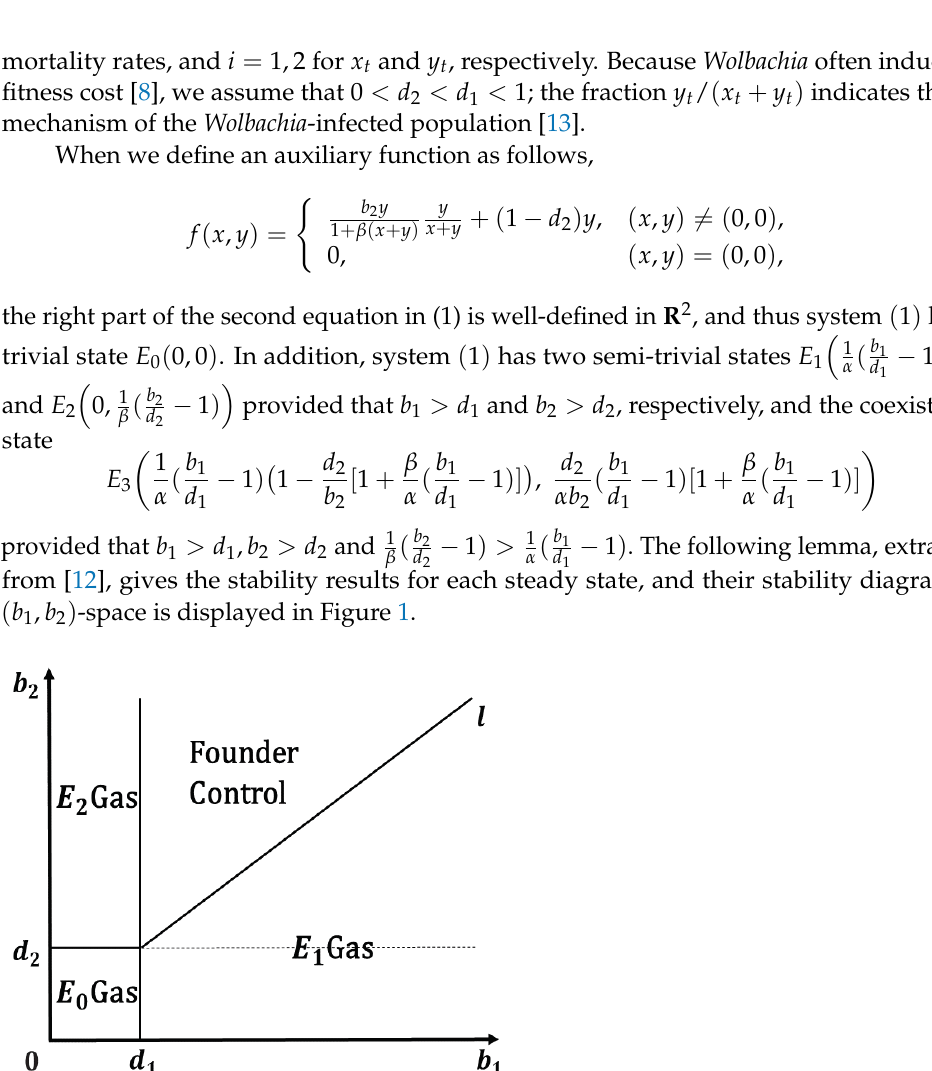
− 1 ) = 1 − 1 ) is a bifurcation ( b 2 ( b 1 α β d 2 d 1